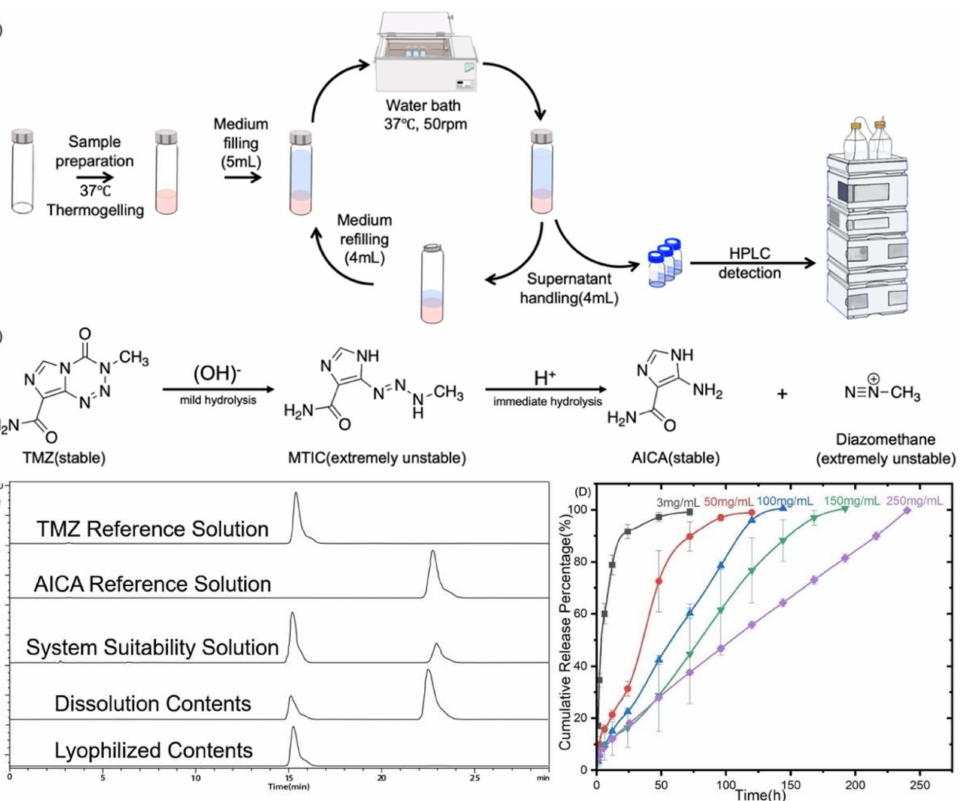
Figure 7. The drug release profile of micro-TMZ@PLGA–PEG–PLGA hydrogel in the pH 7.4 PBS dissolving medium. ( A ) Workflow of the membraneless dissolution process. ( B ) Destiny of TMZ presence under aqueous condition. ( C ) HPLC diagrams of TMZ, AICA, system suitability